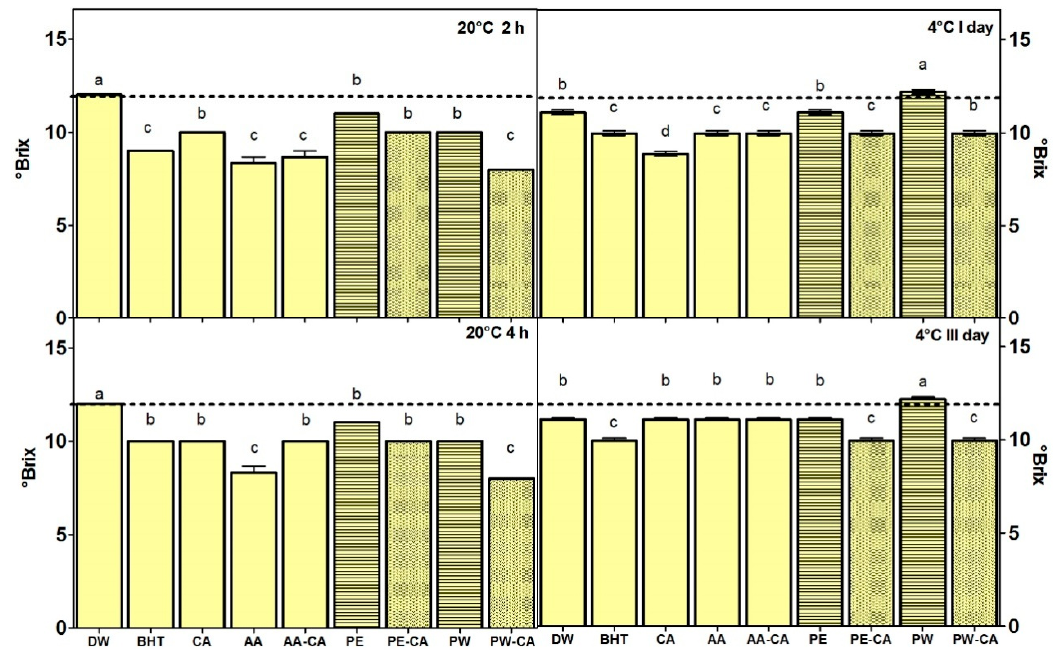
Figure 3. Total solid content (TSS) expressed as °Brix of fresh-cut apples treated with different preservative media (sample codes are described in Table 1). Dotted line represents the initial value. Data are referred to storage at 20 ± 1 °C (2 and 4 h) and 4 ± 1 °C (1 and 3 days). Values are means ± SE and different letters indicate significant statistical difference ( p ≤ 0.05).